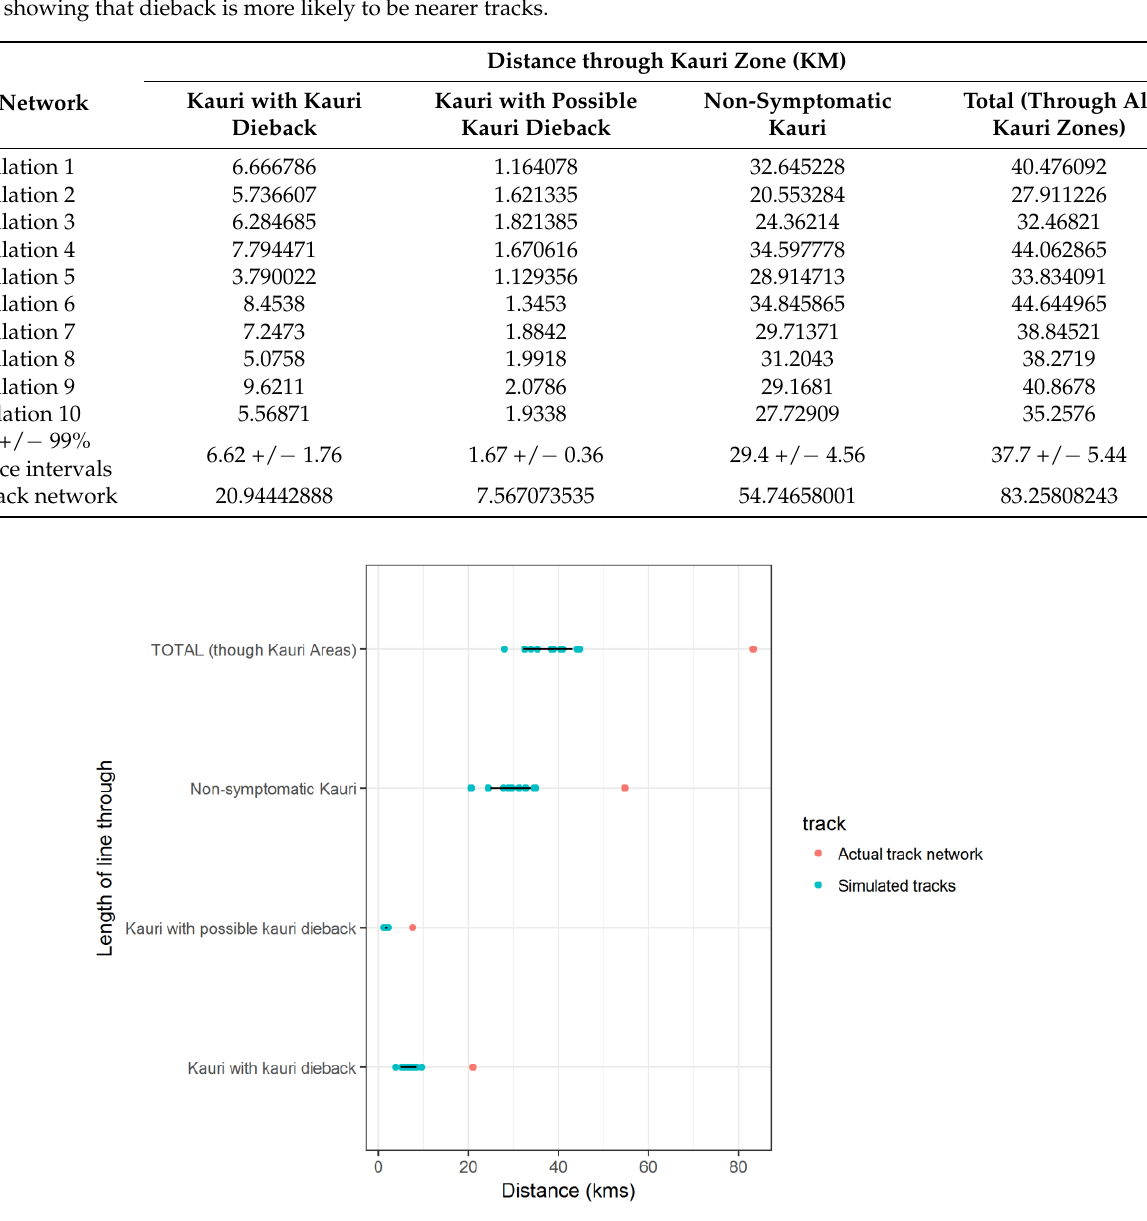
Figure 5. Comparison of dieback along tracks (km) between actual data from this survey and simulated tracks of the same length showing that dieback is more likely to be nearer tracks. Black lines are the 99% CIs from the simulated tracks. Table 3. Comparison of dieback along tracks (percentage) between actual data from this survey and simulated tracks of the same length showing that dieback is more likely to be nearer tracks.